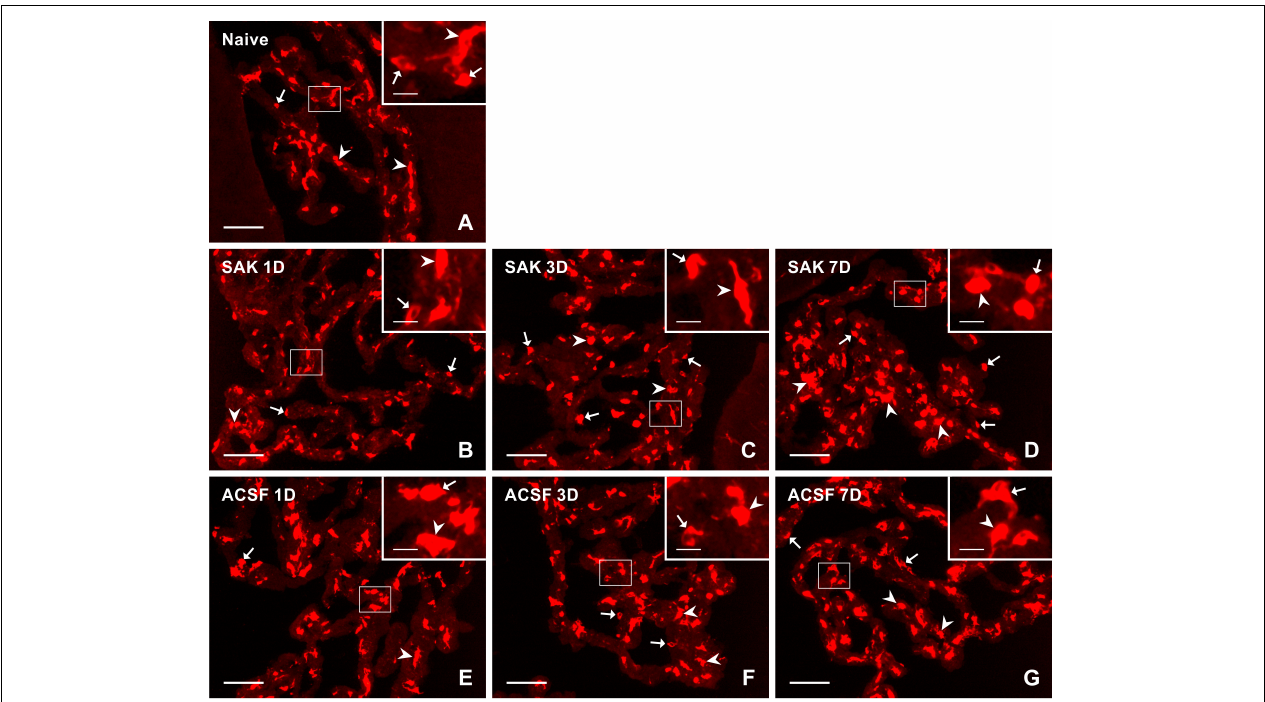
FIGURE 6 | Representative pictures of cryostat sections through the CP showing immunostaining with MHC II antibody from naïve (A) , SAH (B–D), and ACSF (E–G) rats at 1, 3, and 7 days (1D, 3D, and 7D) after operation. Arrows indicate MHC II+ cells in the epiplexus position and arrowheads in the stroma of CP. Insets show a higher magnification of regions marked by the boxes. Scale bars = 80 µ m (main image); 10 µ m